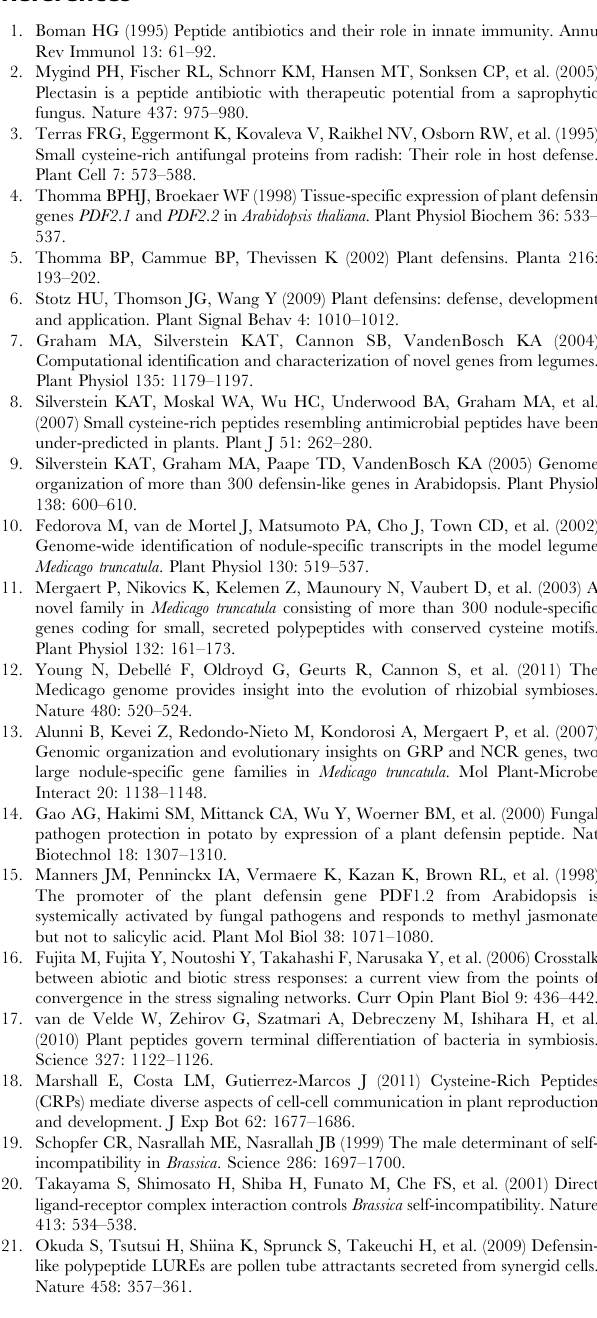
Table S12 Primer sequences of Arabidopsis genes used in this study. (XLSX) Text S1 Development of the custom AtMtDEFL array and robust data normalization methods. Mapping Medi- cago probe sets to the latest annotation of the Medicago gene